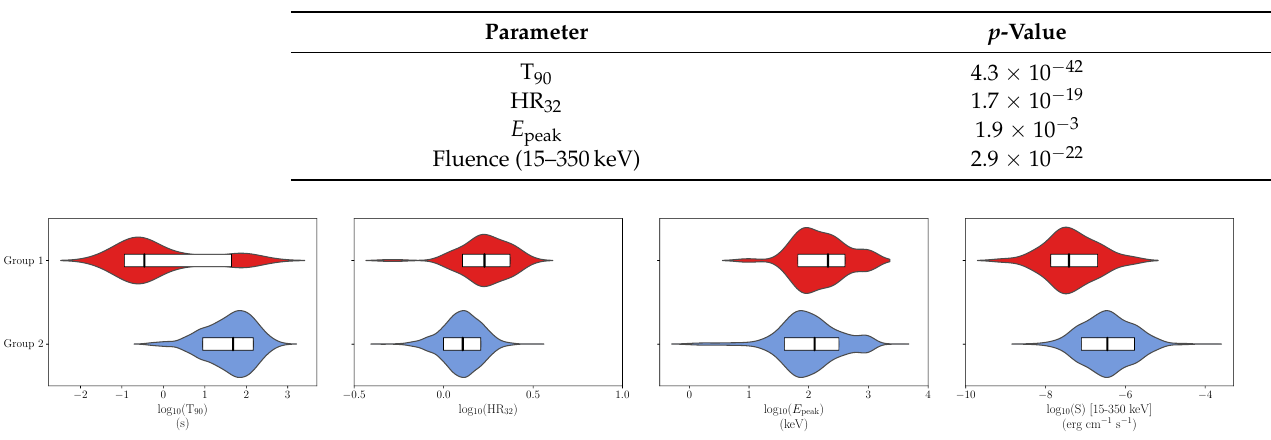
Table 1. Results of the 2D KS test comparing Group 1 and Group 2 identified within the first second of prompt emission of Swift /BAT bursts.